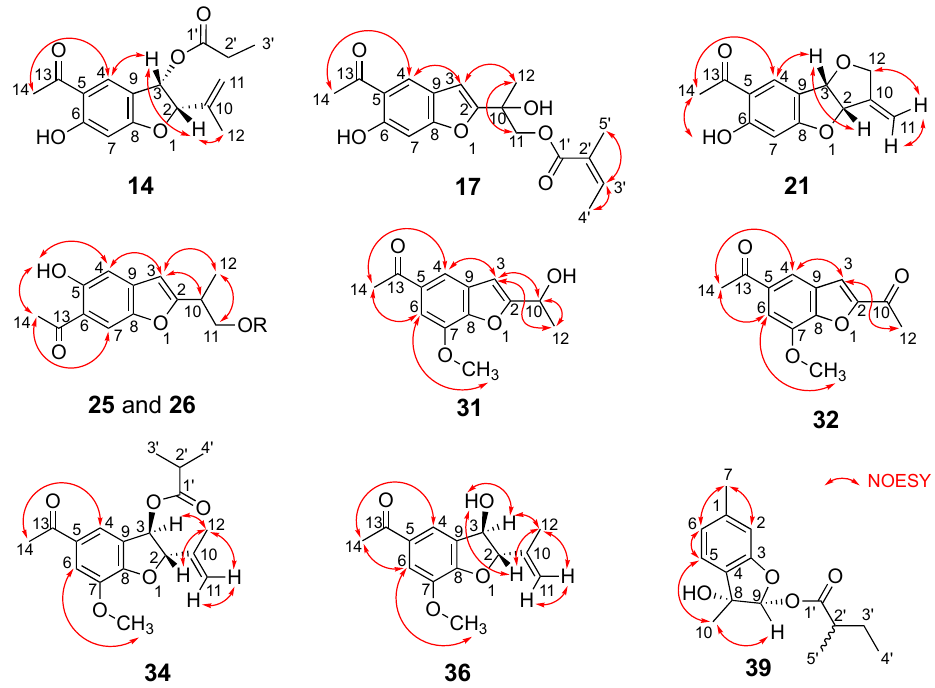
Figure 8. Key NOESY correlations for 10 new compounds.